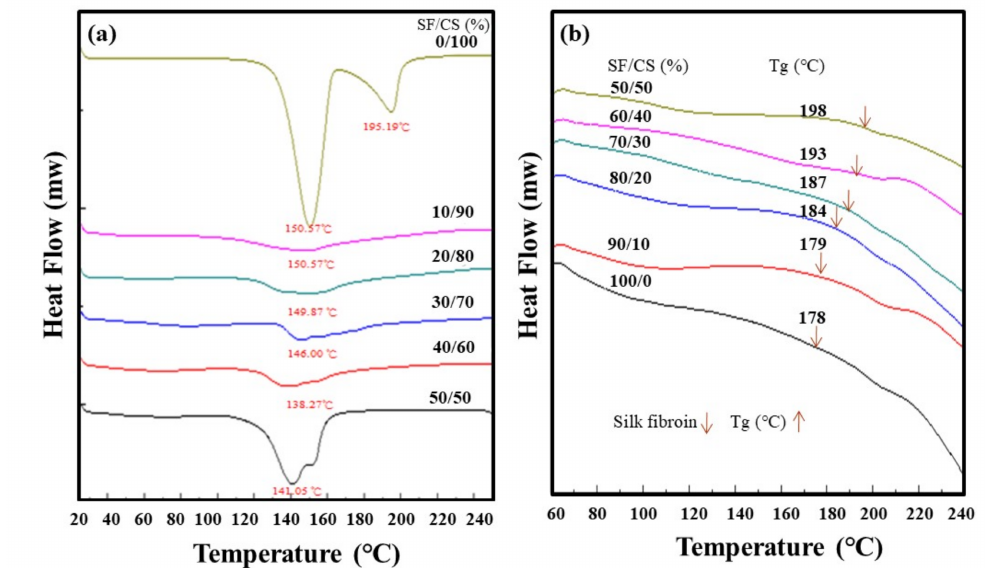
Figure 2. ( a ) DSC first heating curves of CS-dominating composites; ( b ) DSC second heating curves of SF-dominating